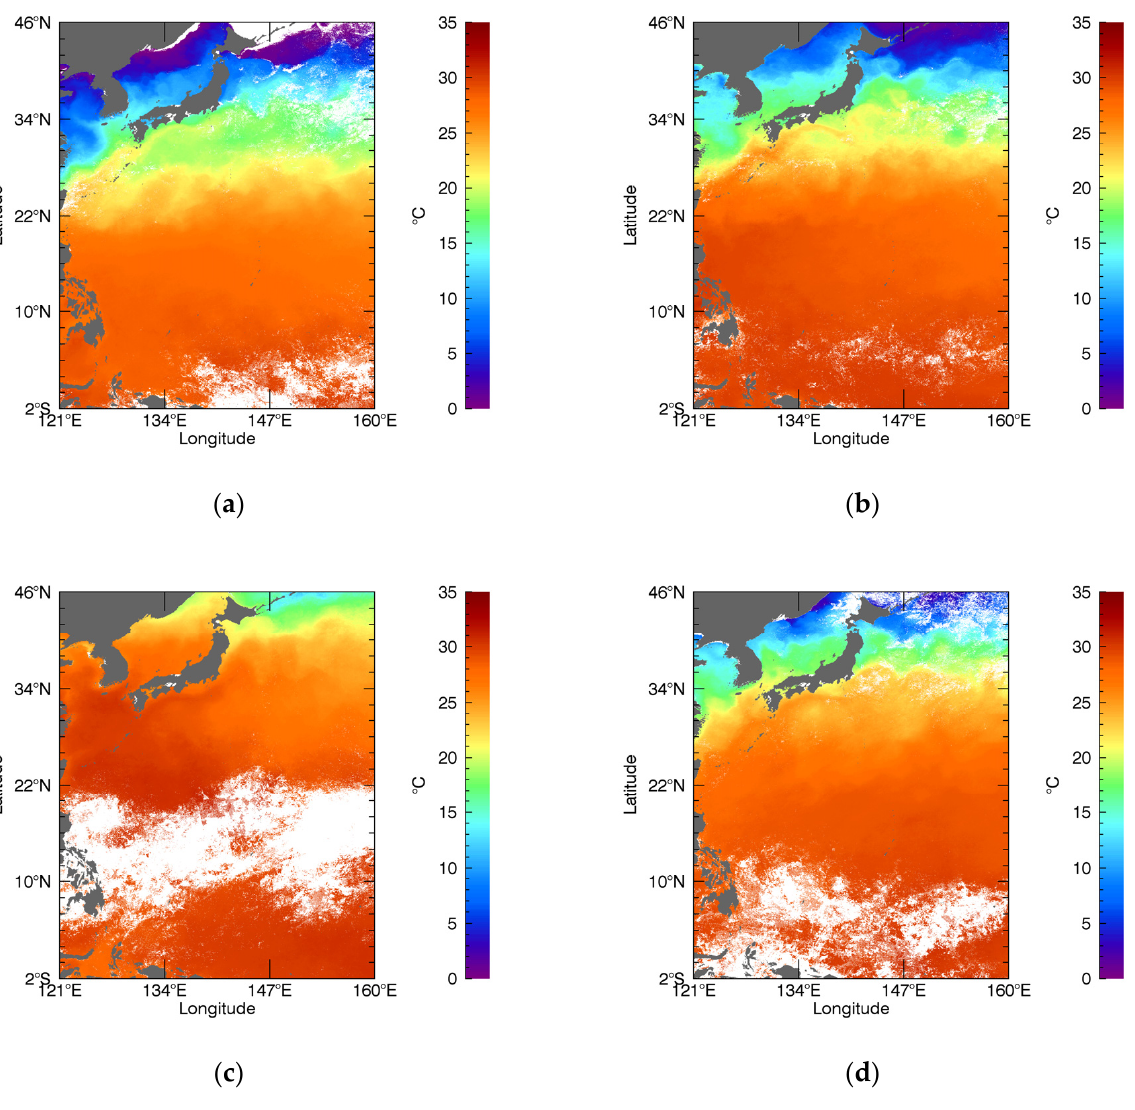
Figure 14. The VIRR monthly mean SST of March, May, August, and November: ( a ) March; ( b ) May; ( c ) August; ( d ) November.